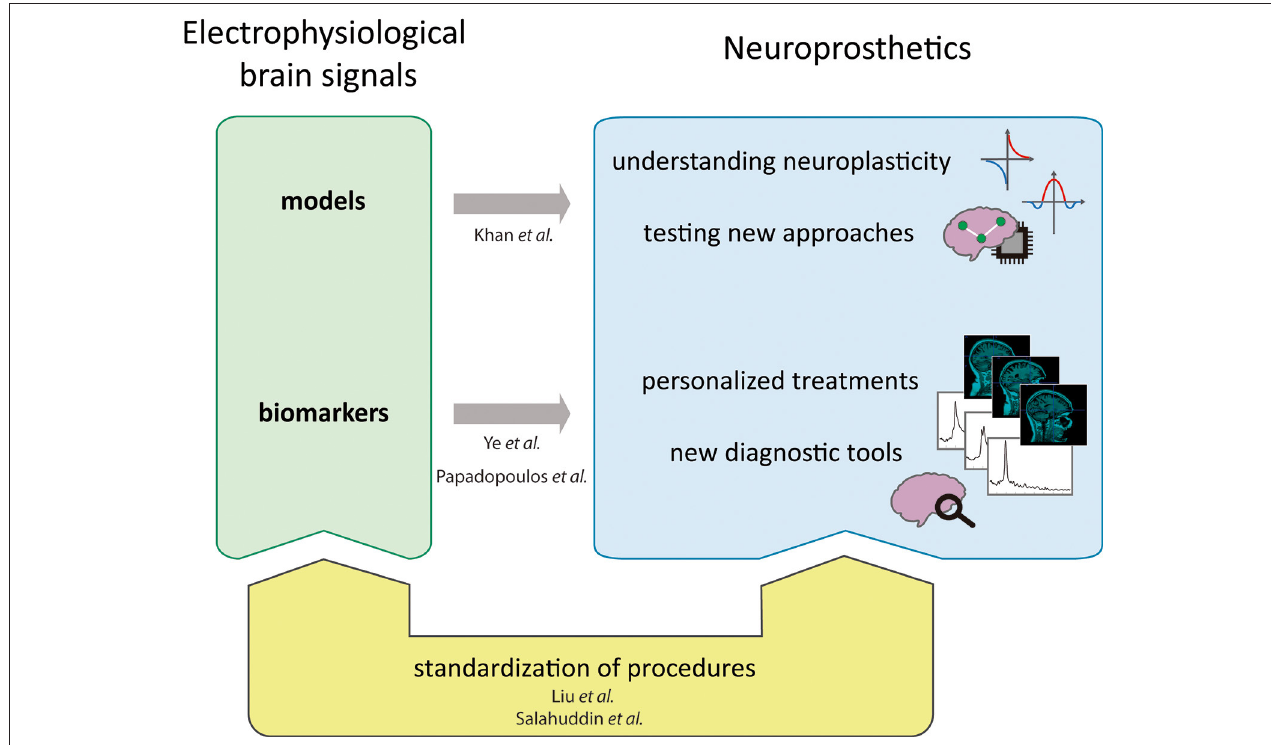
FIGURE 1 | A framework for the adoption of non-invasive electrophysiological brain signals for neuroprosthetics and how the presented works fit in